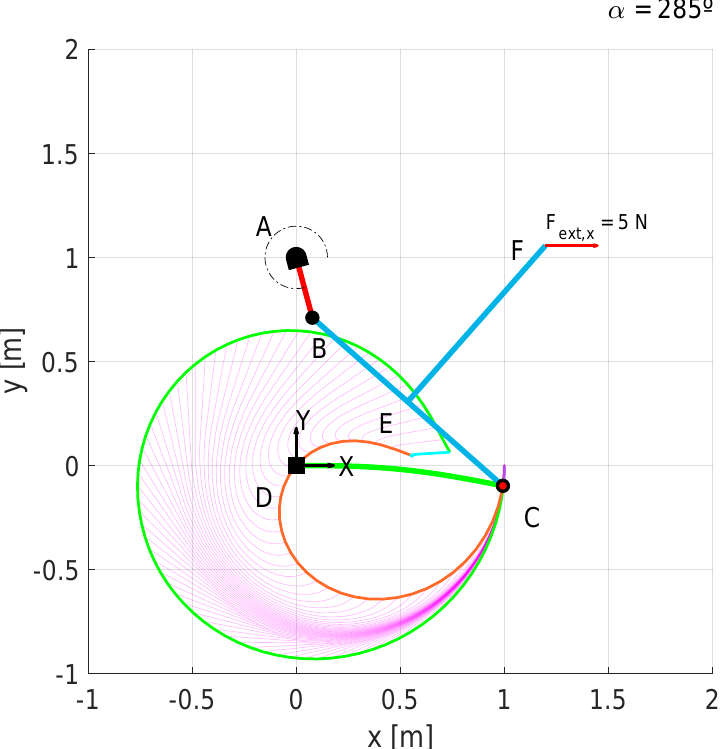
Figure 14. Cycle with buckling mode changes. Mode 2 to Mode 1 change.